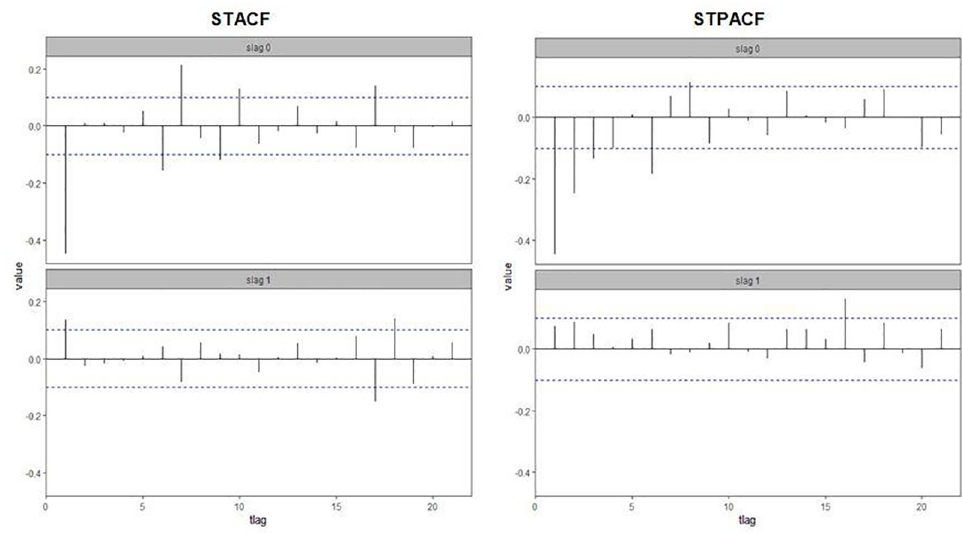
Fig 6. STACF and STPACF of the differenced